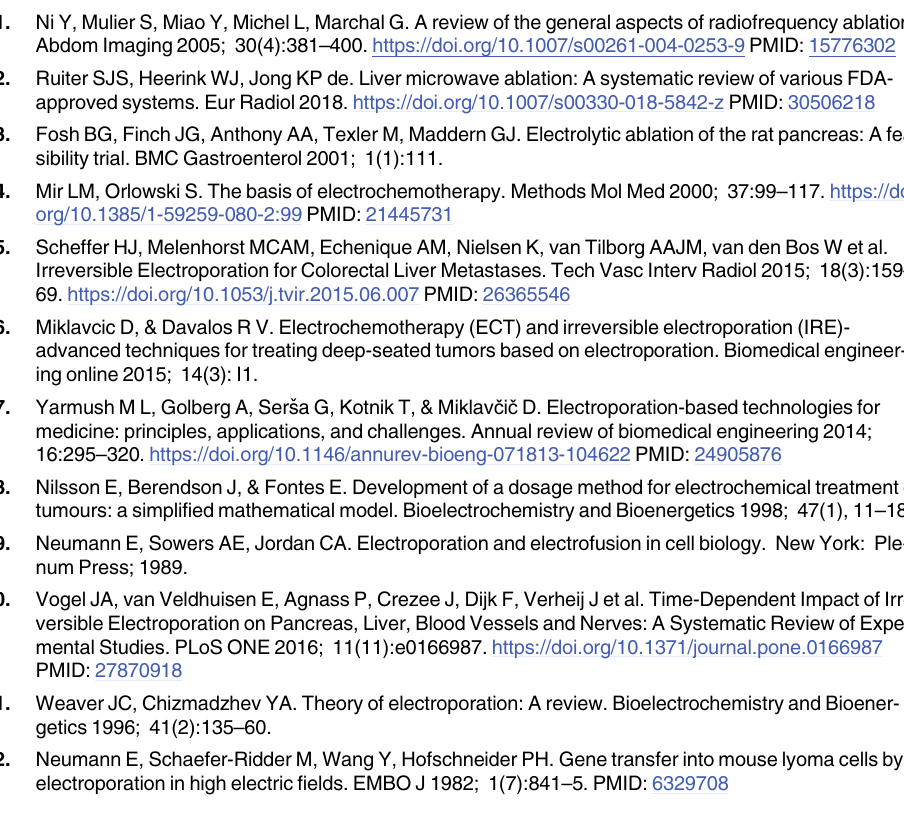
S4 Fig. Non-continuous lesion of a bipolar electrode. 15-15-15mm were used as anode-isola- tion-cathode lengths, respectively, employing 3x1200V peak voltage for the waveforms and 193 μ F charge. Image shows the measurements of the lesion.